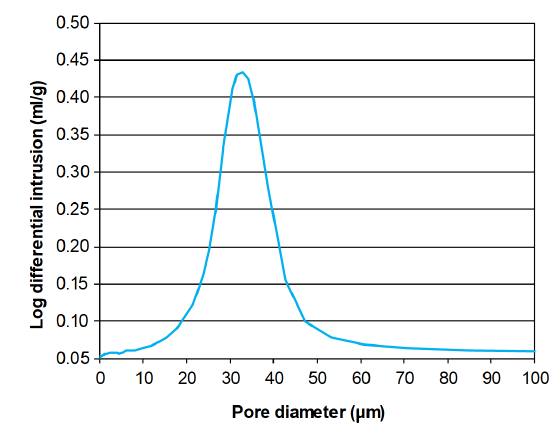
Figure 4. Pore size distribution for Bentheimer